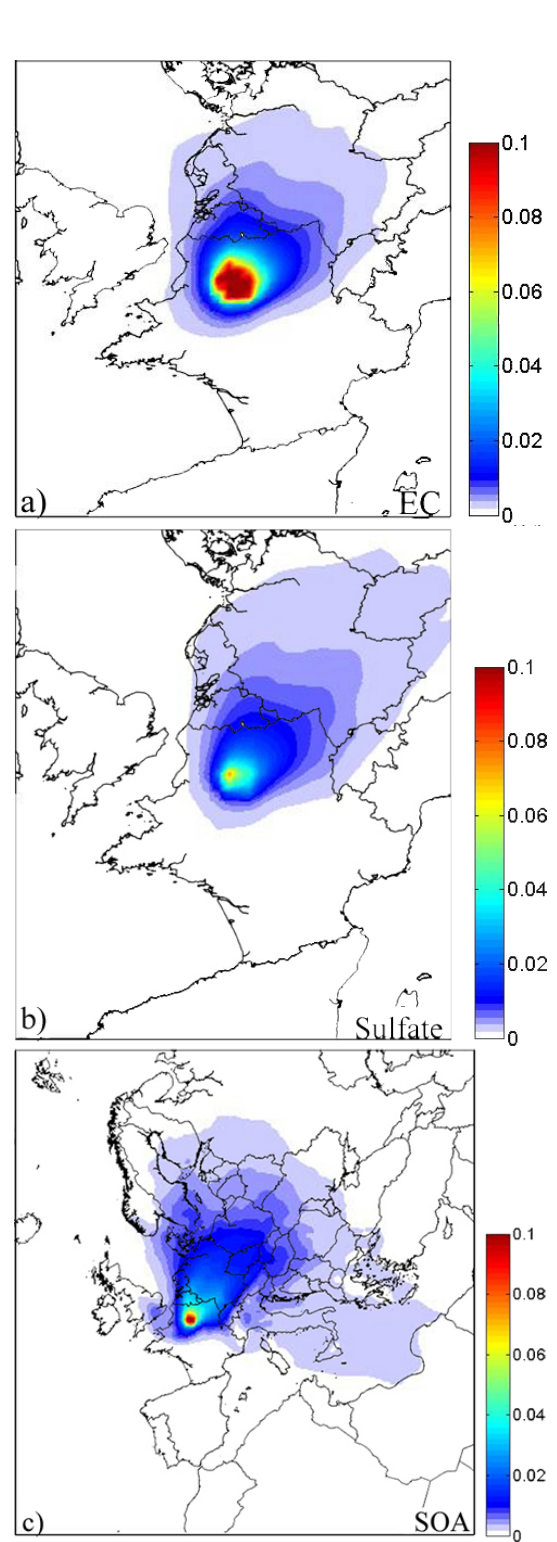
Fig. 7. Simulated average ground concentrations (in µgm − 3 ) of PM 2 . 5 : (a) EC, (b) sulfate and (c) SOA originating from the Paris